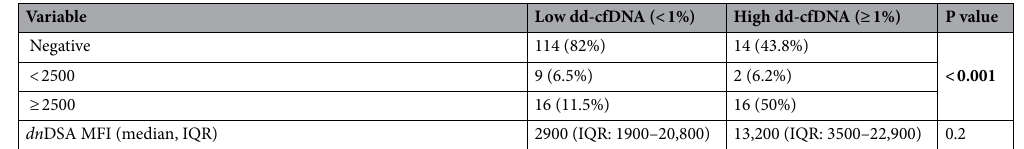
Table 1. Baseline patient characteristics according to the level of dd-cfDNA. dd-cfDNA, donor-derived cell-free DNA; dn DSA, de novo donor-specific antibody; MFI, mean fluorescence intensity; eGFR, estimated glomerular filtration rate; UPCR, urine protein:creatinine ratio.